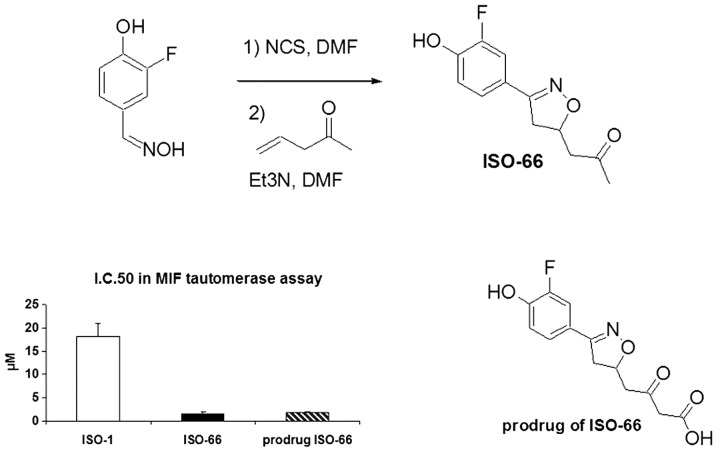
Synthesis of ISO-66 and IC50 in MIF tautomerase assay of ISO-1, ISO-66 and the prodrug of ISO-66 (ISO-1, 18.2±2.8 μM; ISO-66, 1.5±0.4 μM; prodrug of ISO-66, 1.8±0.1 μM).